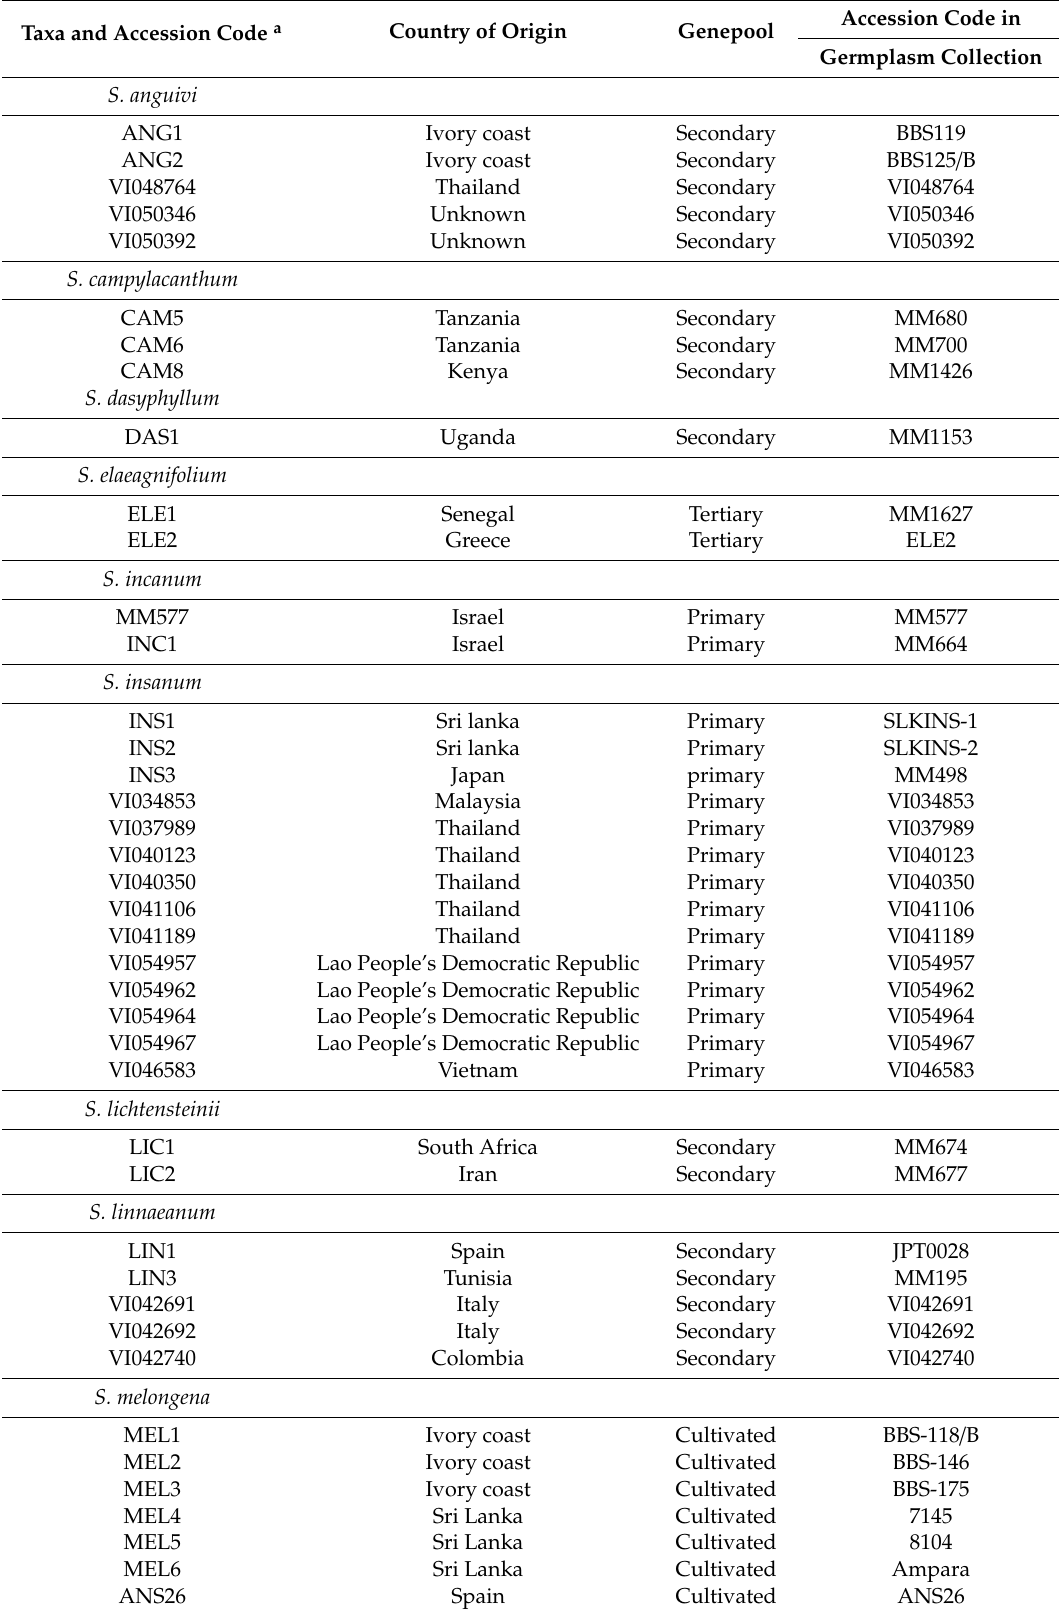
Table 1. Cultivated eggplant and wild relatives used for evaluation for resistance to bacterial